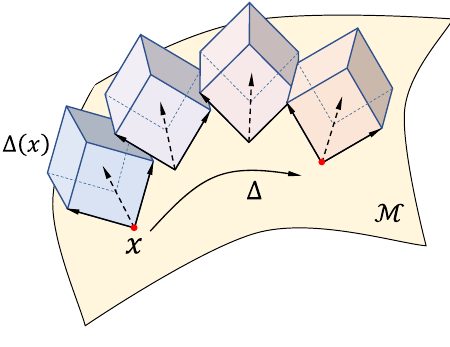
Figure 1. Relationship between distribution and tangent